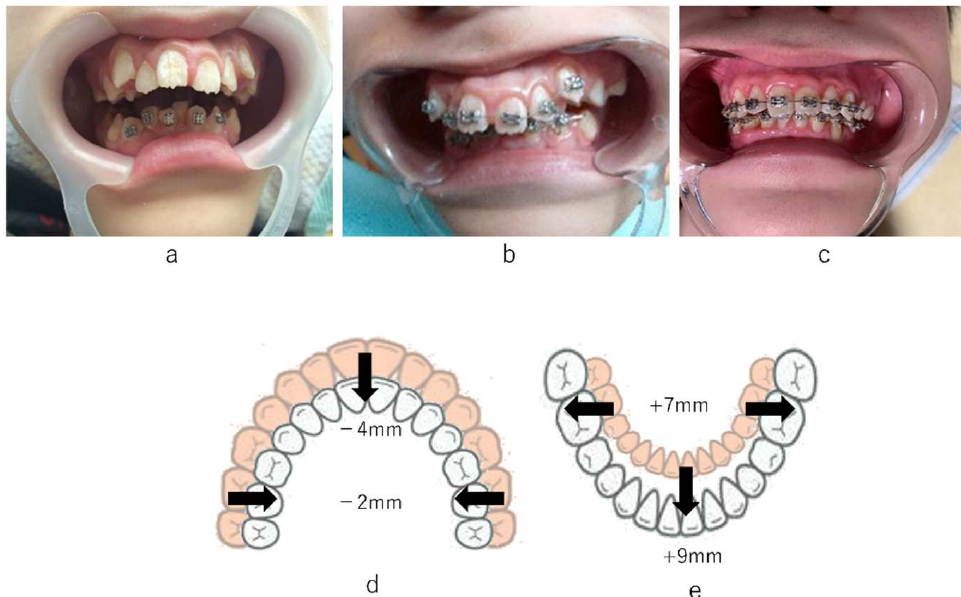
Figure 2. Prognosis of orthodontic treatment. ( a ): Fixed multi-bracket appliance placed on the mandibular anterior teeth (2 months after starting orthodontic treatment). ( b ): Fixed multi-bracket appliance placed on the maxillary anterior teeth (7 months after starting orthodontic treatment). ( c ): View of the anterior teeth at 6 years after the initiation of orthodontic treatment. ( d ): The length and width of the upper arch decreased by 4 mm and 2 mm, respectively. ( e ): The length and width of the lower arch increased by 9 mm and 7 mm, respectively.